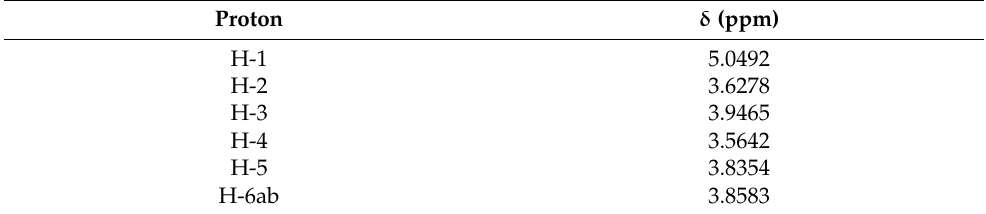
Table A1. Assigned peaks from 400 MHz 1 H-NMR of β -CD in D 2 O. Protons are labeled according to Figure 7 of the repeating unit of β -CD.